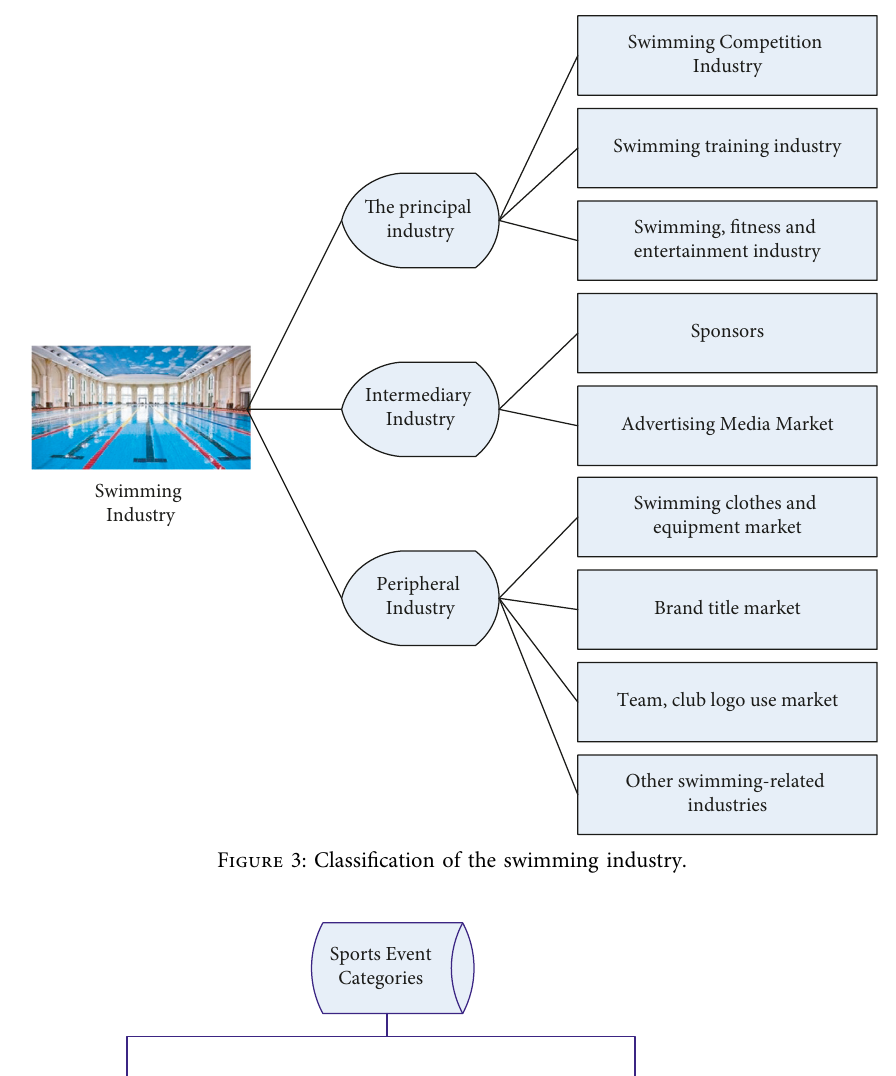
Figure 3: Classification of the swimming industry.